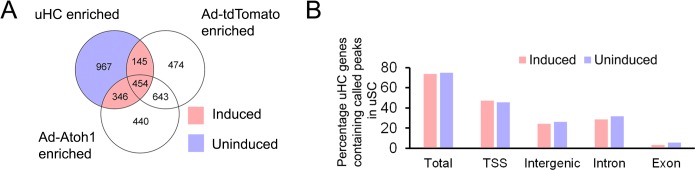
Analysis of hair cell gene up-regulation in supporting cells.(A) Venn diagram showing identification of hair cell genes that are up-regulated in supporting cells by Atoh1 transduction (945 genes) compared to hair cell genes that failed to be activated by Atoh1 (967 genes). (B) Analysis of ATAC-seq data from 1912 utricle hair cell gene loci showing the proportion of loci containing accessible peaks in genes that were induced by Atoh1 versus those that were not induced by Atoh1. TSS: transcription start site.